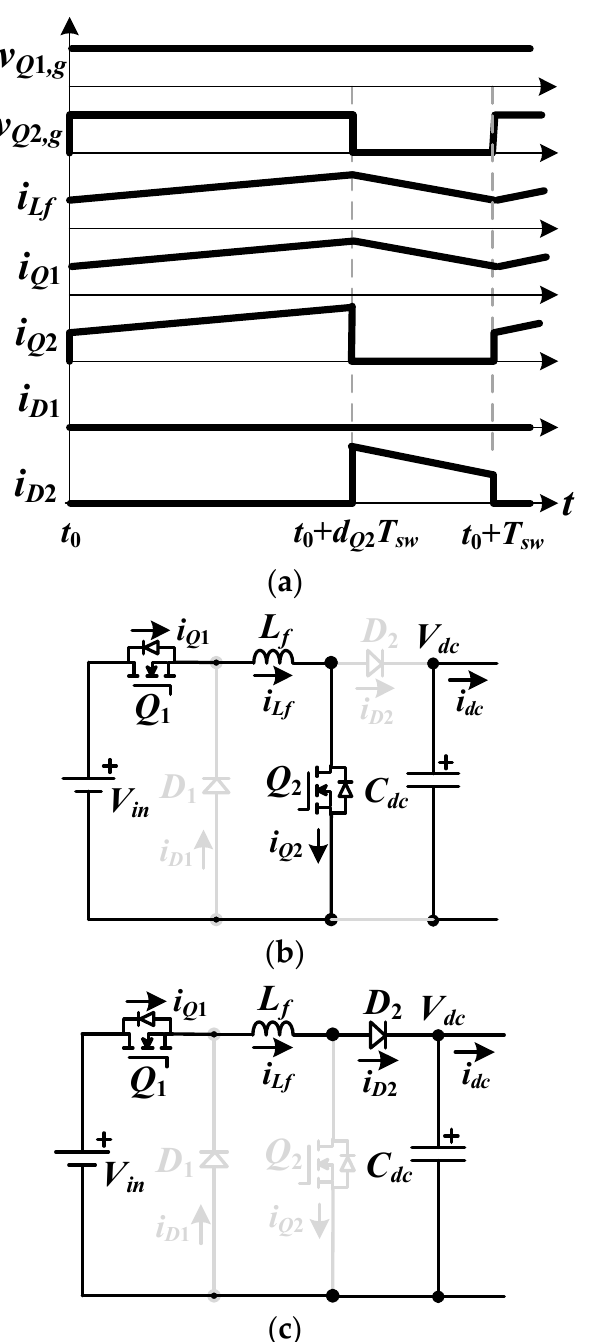
Figure 3. Buck/boost converter under low voltage range (boost operation) ( a ) pulse-width modula- tion (PWM) signals ( b ) mode 1 equivalent circuit ( c ) mode 2 equivalent circuit. Mode 2 [ t 0 + d Q 2 T sw ~ t 0 + T sw ]: At t = t 0 + d Q 2 T sw , Q 2 is turned off. The inductor i Lf flows through D 2 to charge C dc . The inductor voltage v Lf = V in − V dc < 0 so that i Lf decreases. The drain-to-source voltage of Q 2 is equal to the DC bus voltage V dc . Mode 2 is ended at time t 0 + T sw